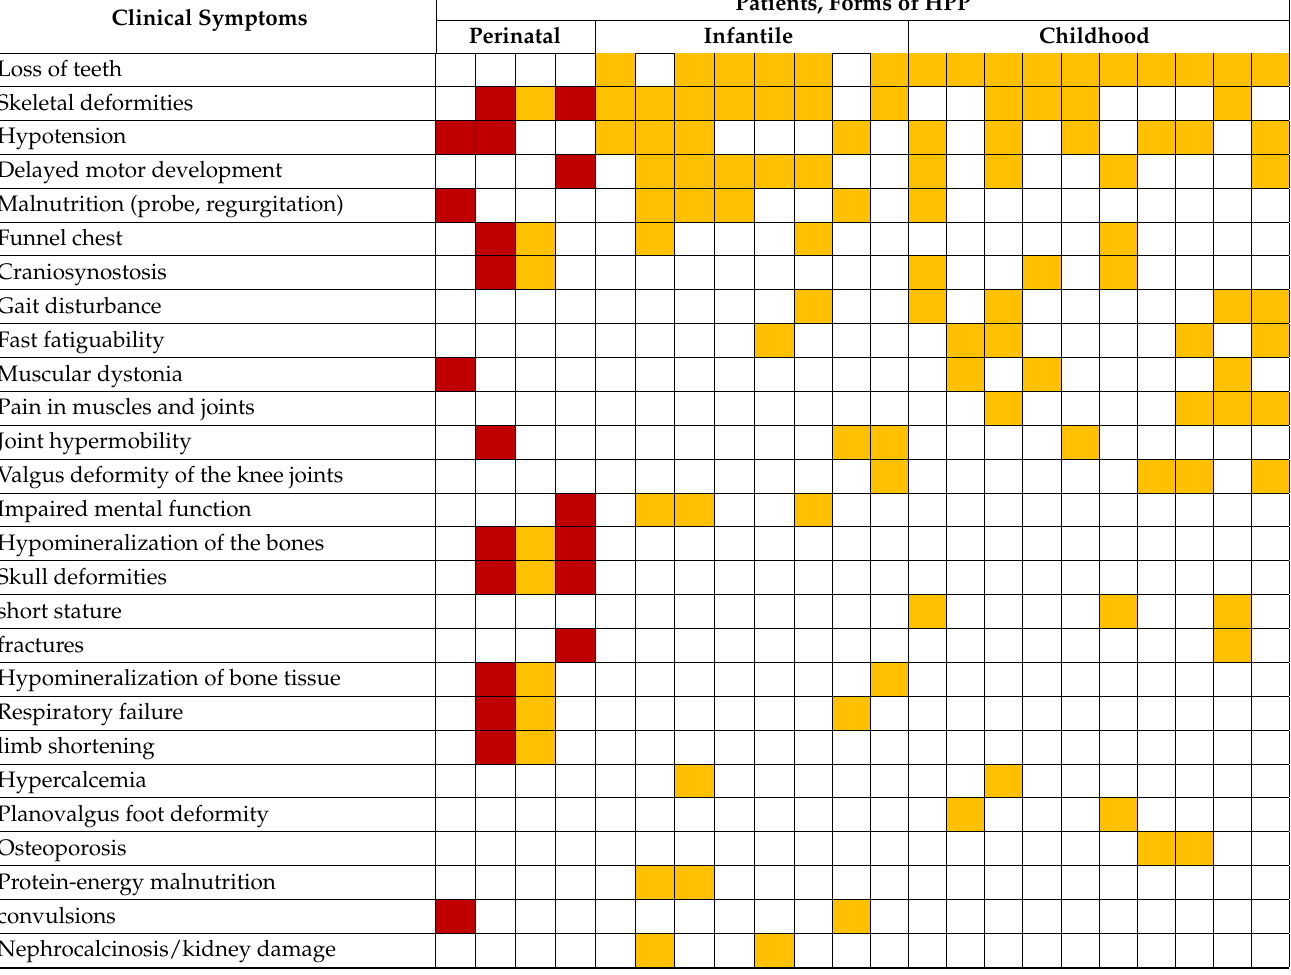
Table 4. Correlation of clinical symptoms with variants in the ALPL gene in Russian patients with perinatal, infantile, and childhood forms of